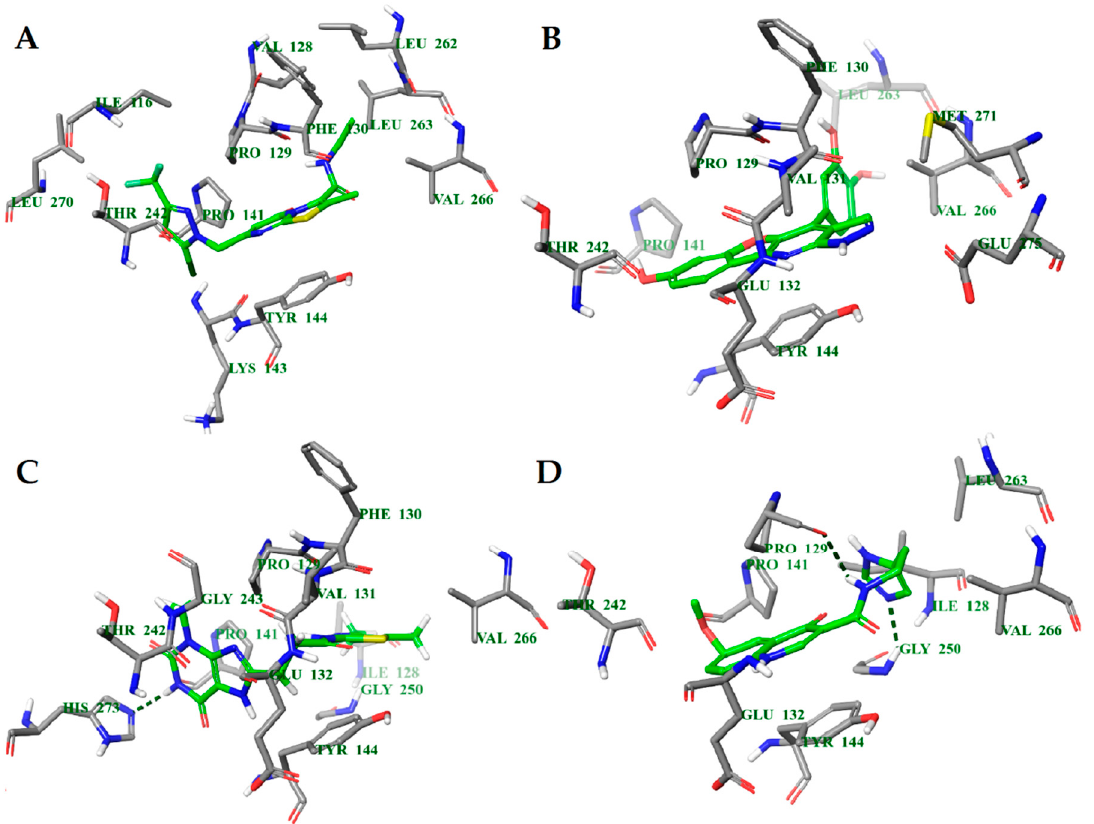
Figure 3. Calculated binding modes of ligands in the active site of NMDA (PDB ID: 5TP9): ( A ) compound GNE-5729, ( B ) compound 1N , ( C ) compound 2N , ( D ) compound 3N . The amino acid residues of NMDA are colored gray (carbon), blue (nitrogen), red (oxygen), and white (hydrogen). Hydrogen bonds formed between compounds and residues of NMDA are represented by green dashed lines.